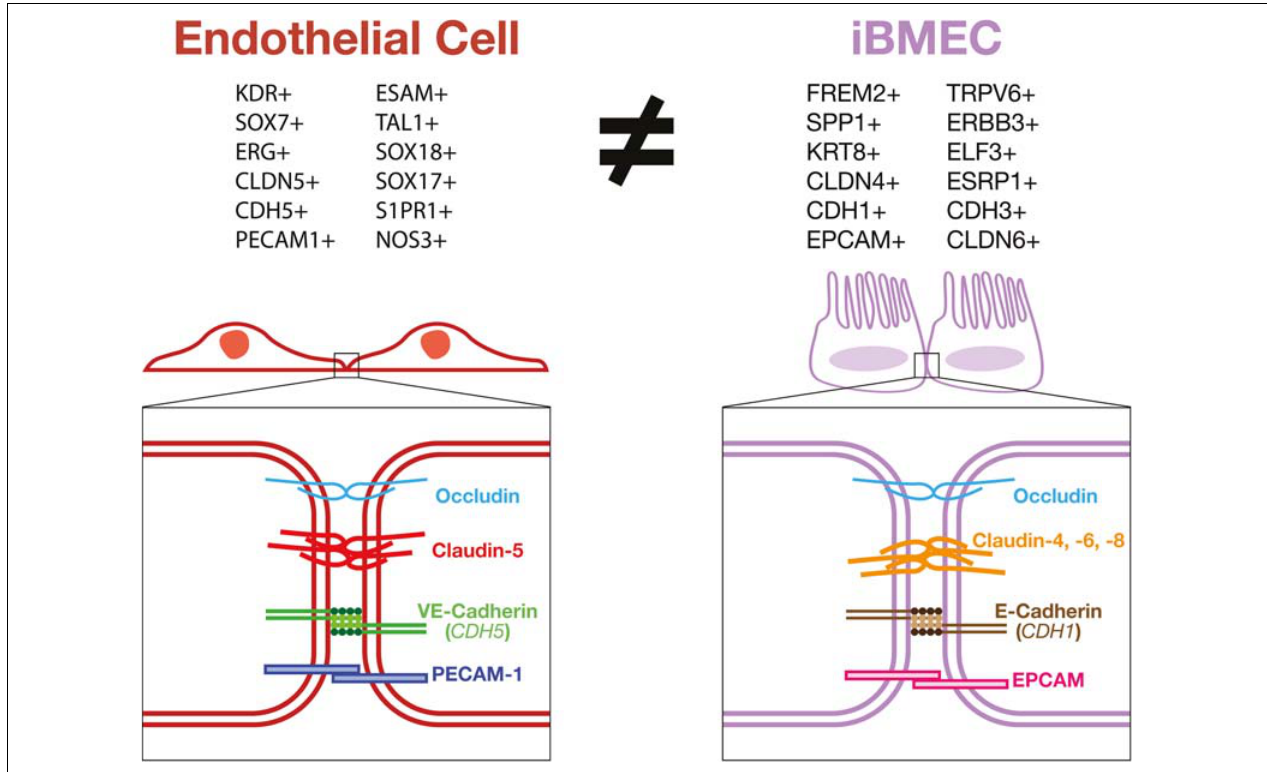
FIGURE 3 | iBMECs do not possess an endothelial transcriptional profile or vascular junctional components. iBMECs are shown to lack expression of phenotypical markers of a vascular EC lineage while expressing many epithelial cell lineage genes by bulk and single-cell RNA sequencing methods. The junctional components in iBMECs are also incongruent with canonical EC junctions leading to very serious concerns as to the efficacy of their use in an in vitro vascular BBB model.